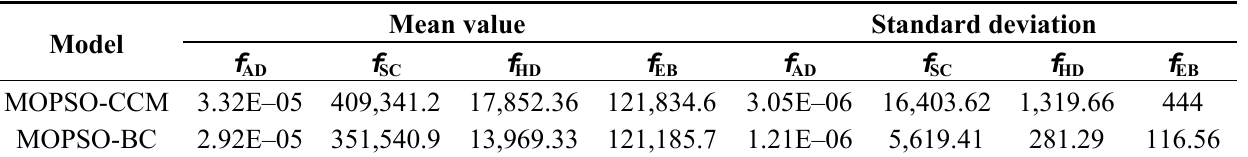
Table 11. The mean values and standard deviation of each sub-objective when the MOPSO-CCM and MOPSO- BC models are run 100 times.